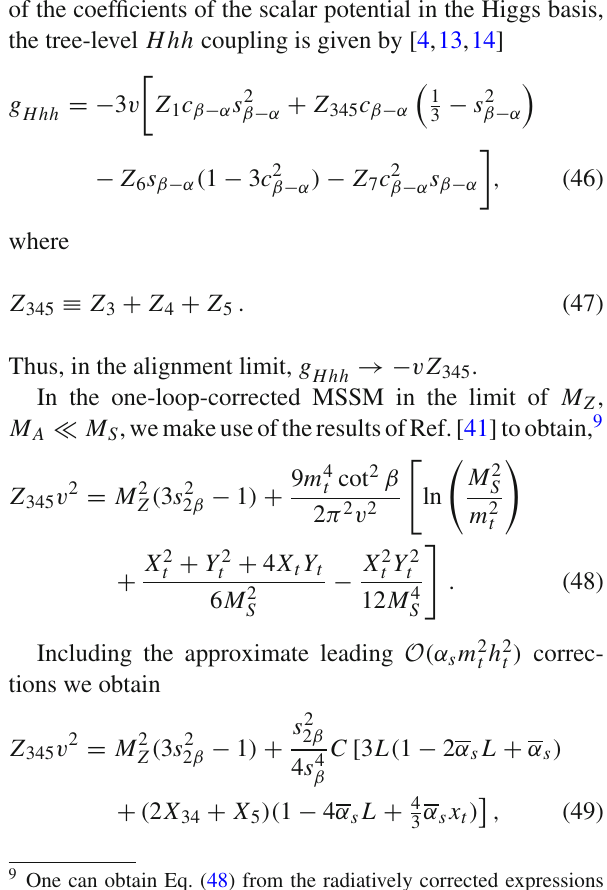
Fig. 6 Contours of Z 345 in the exact alignment, corresponding to the strength of the Hhh coupling in the heavy Higgs interpretation. These results correspond to the first alignment solution displayed in the top